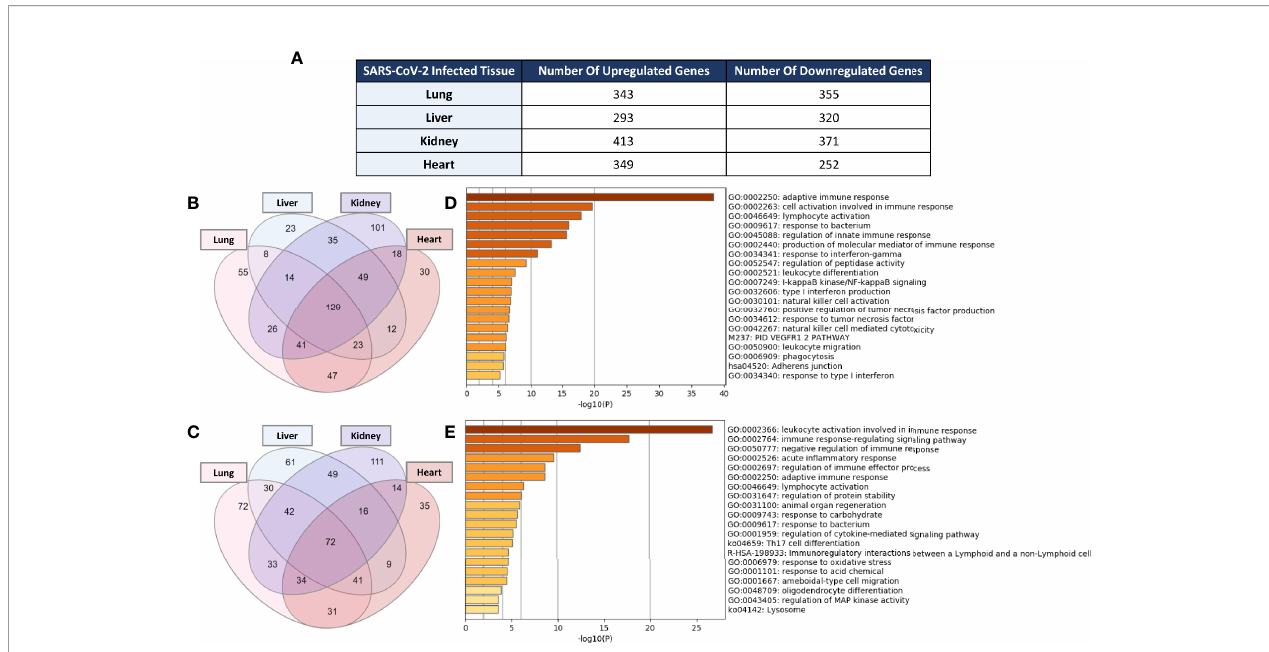
FIGURE 1 | (A) Count of differentially expressed immune response genes from the immune response gene ontology set (GO:0006955) in SARS-CoV-2 infected lung, liver, kidney, and heart tissues. Venn diagram representation of the overlap of signi fi cantly (B) upregulated and (C) downregulated immune response genes amongst the four types of infected tissues. Functional clustering and pathway analysis of the commonly (D) upregulated and (E) downregulated genes across lung, liver, kidney, and heart tissues in response to SARS-CoV-2